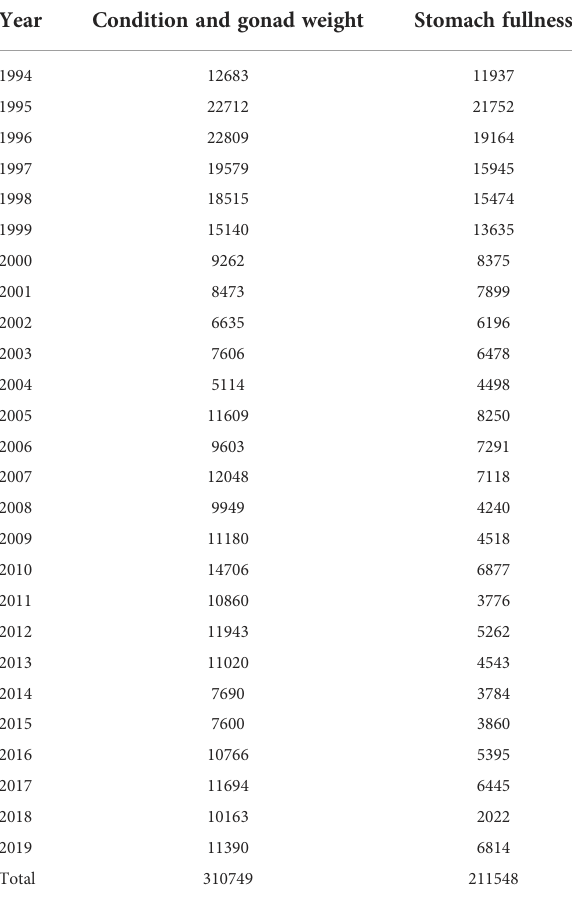
TABLE 1 Number of biological samples by year, with information on age, older than 2 year and west of 22°E.